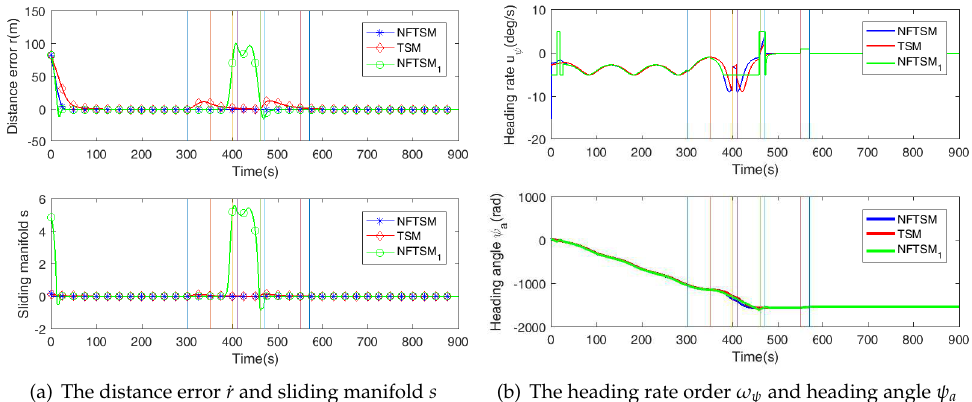
Figure 10. The results of tracking a maneuvering